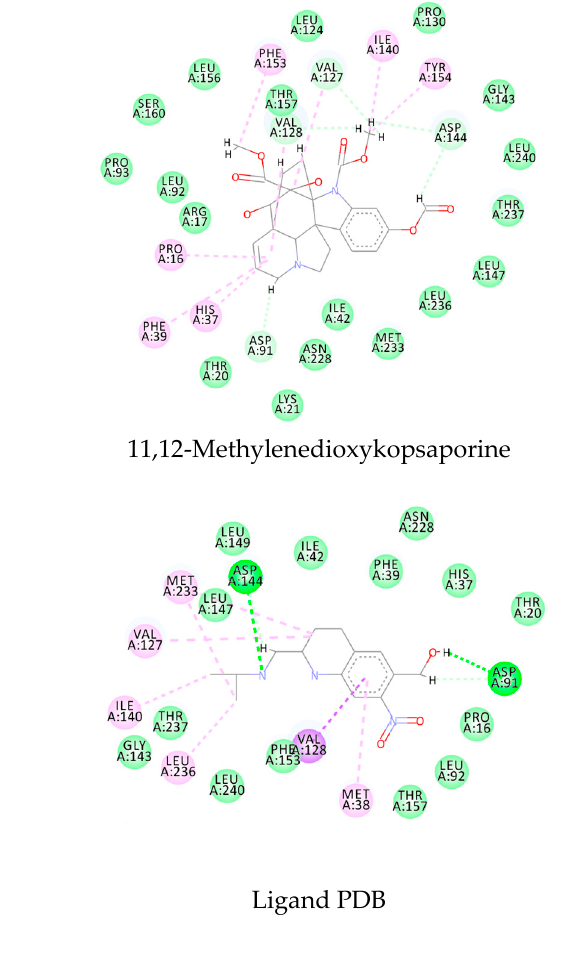
Figure A5. Molecular docking interactions between the five selected VS hits and the 4MUB protein. The light green represents the van der Waals interactions, the green represents the conventional H-bonds, the pink represents the pi-interactions, and the orange represents the pi-sulfur interactions.